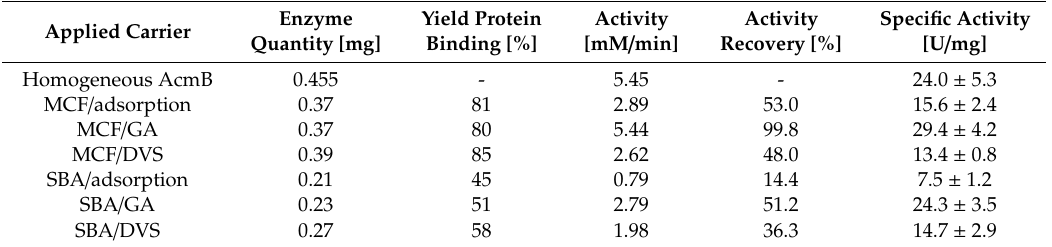
Table 2. Characterization of the silica carriers used in immobilization.